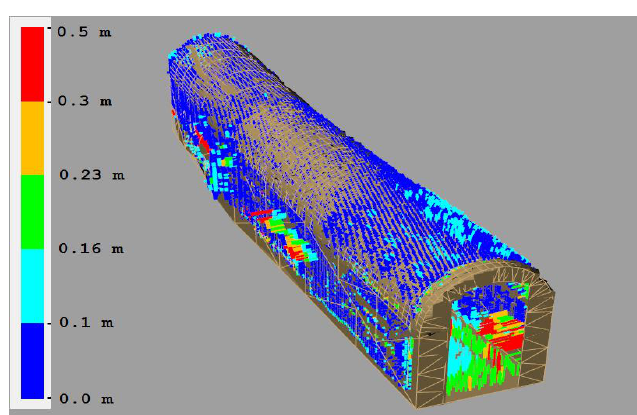
Figure 7. Visualization of difference between the model created based on laser scanning data and geodetic